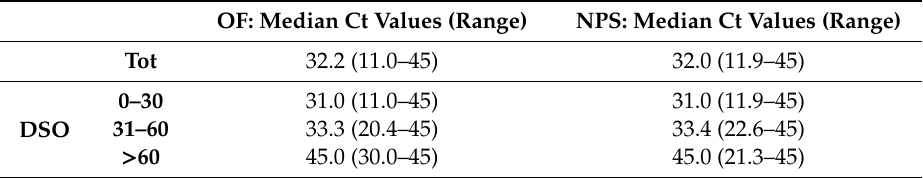
Table 3. Comparison of median Ct values in OF and NPS according to age.